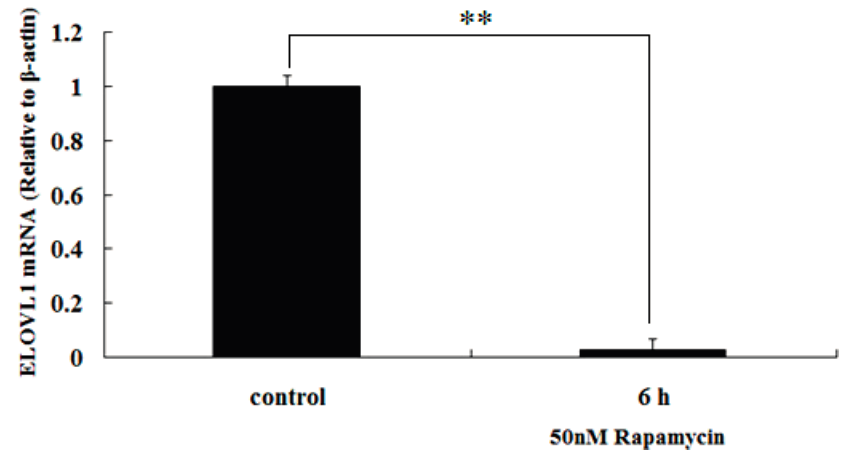
Figure 5. Rapamycin inhibits the relative abundance of ELOVL1 mRNA in GFb cells. Cells were treated with 50 nM rapamycin for 6 h, and ELOVL1 mRNA was detected by real-time qPCR. The relative abundance of ELOV1 mRNA in the treated GFb cells was significantly inhibited (** p < 0.01).